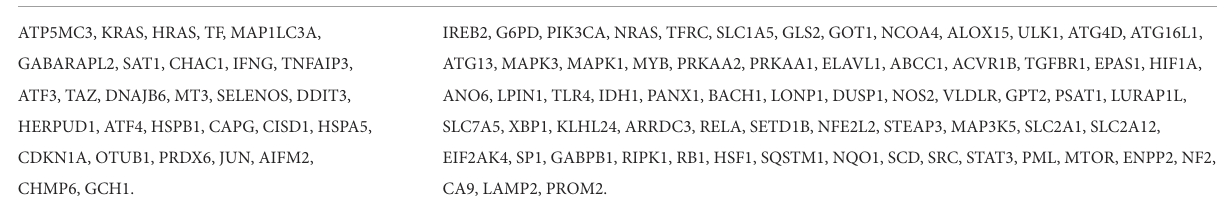
TABLE 2 Differentially expressed ferroptosis genes.